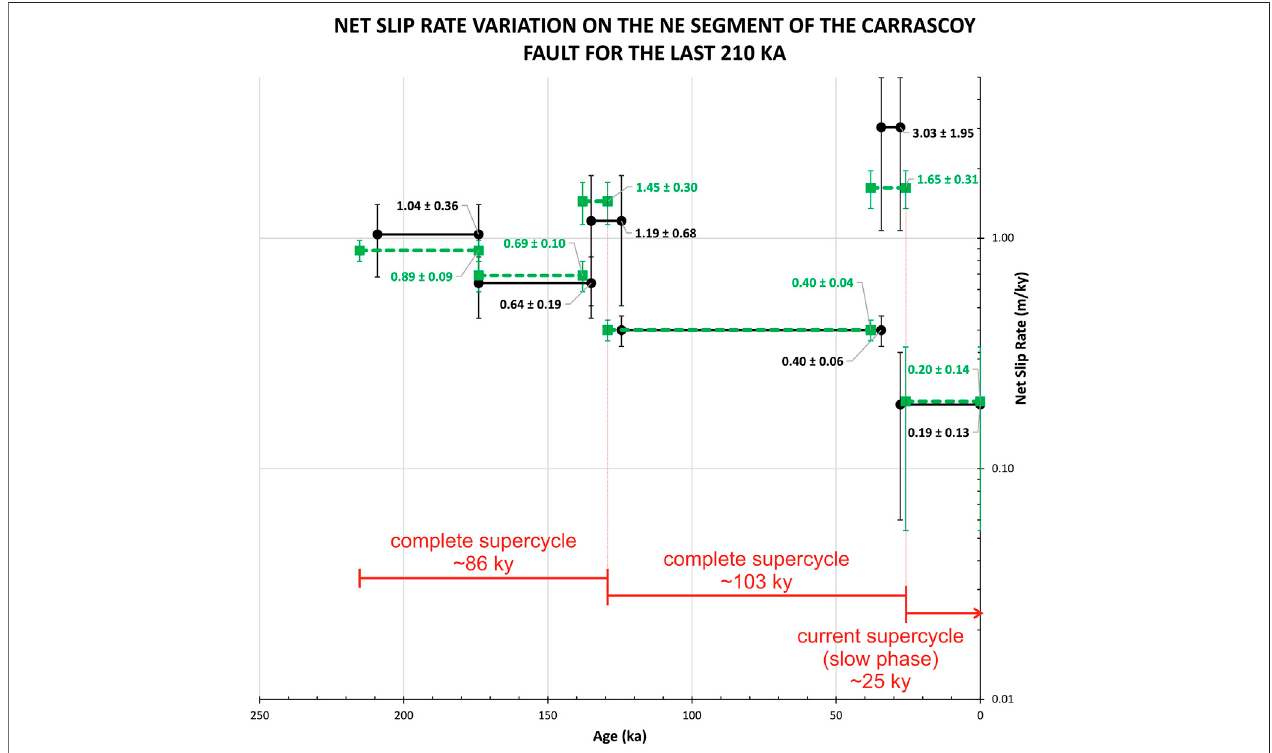
FIGURE9| Netslipratevariation(m/ky)ontheNESegmentoftheCarrascoyFaultforthelast ∼ 210 kaobtainedconsideringtheaverageageofthesamples(black horizontal lines) and the maximum calcrete ages and minimum sediment age (green horizontal lines). Vertical bars: uncertainty range of the net slip rates estimated ( ± 1 standard deviation in both cases). Supercycles interpreted (red horizontal